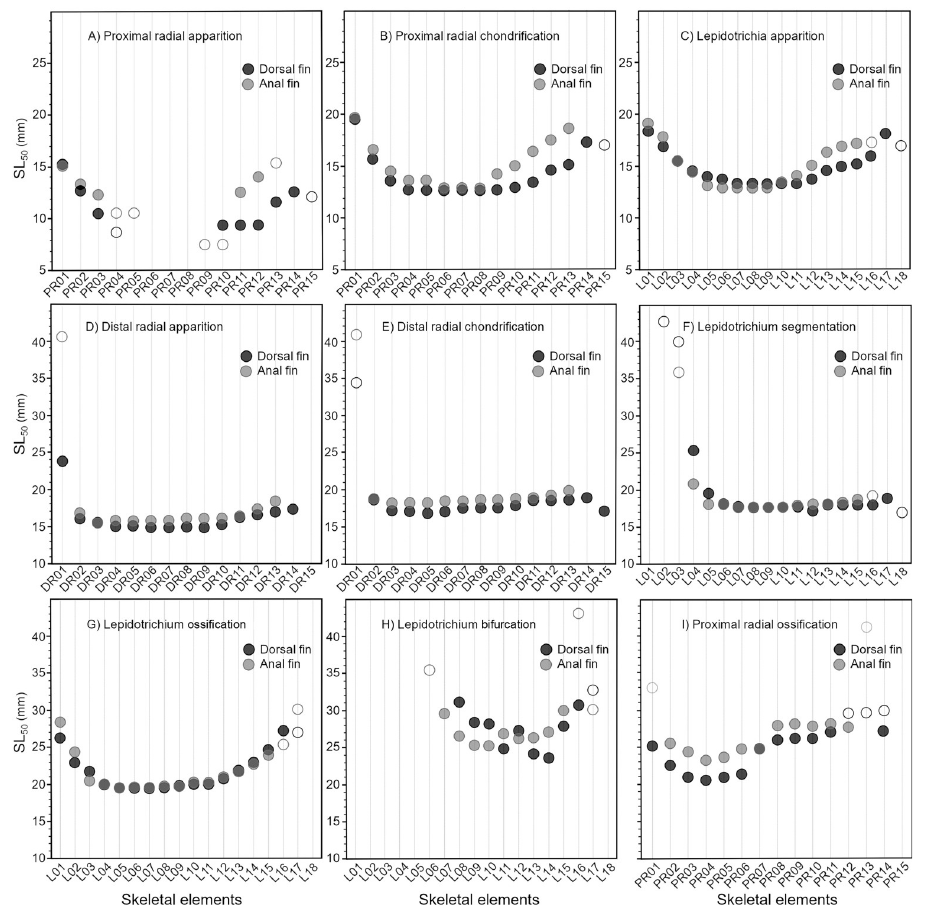
Fig 3. Comparisons between nine out of eleven developmental sequences for the dorsal (black) and anal (gray) fins of the rainbow trout ( Oncorhynchus mykiss ). See Nomenclature for the complete list of events. Skeletal elements are ordered from anterior to posterior. Filled and empty symbols represent significant and non-significant results for SL50,